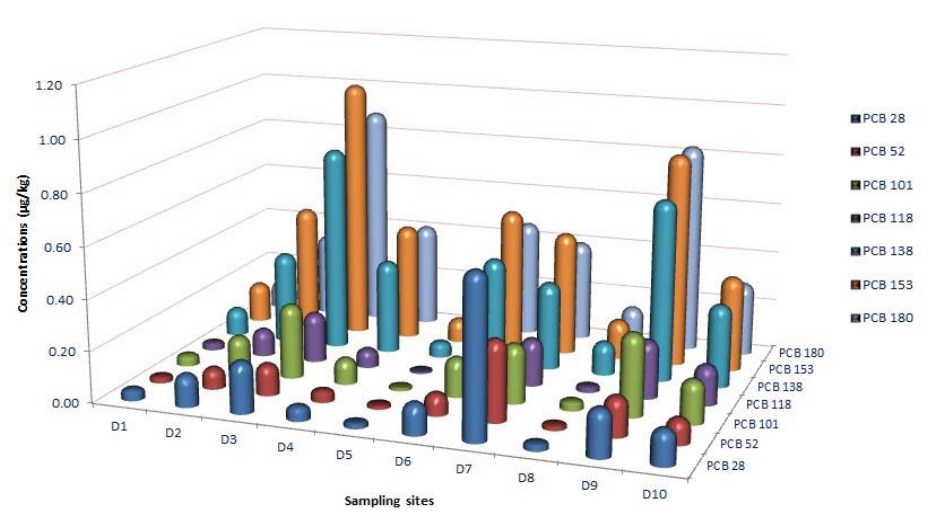
Figure 2. Spatial distribution of PCBs in sediment samples